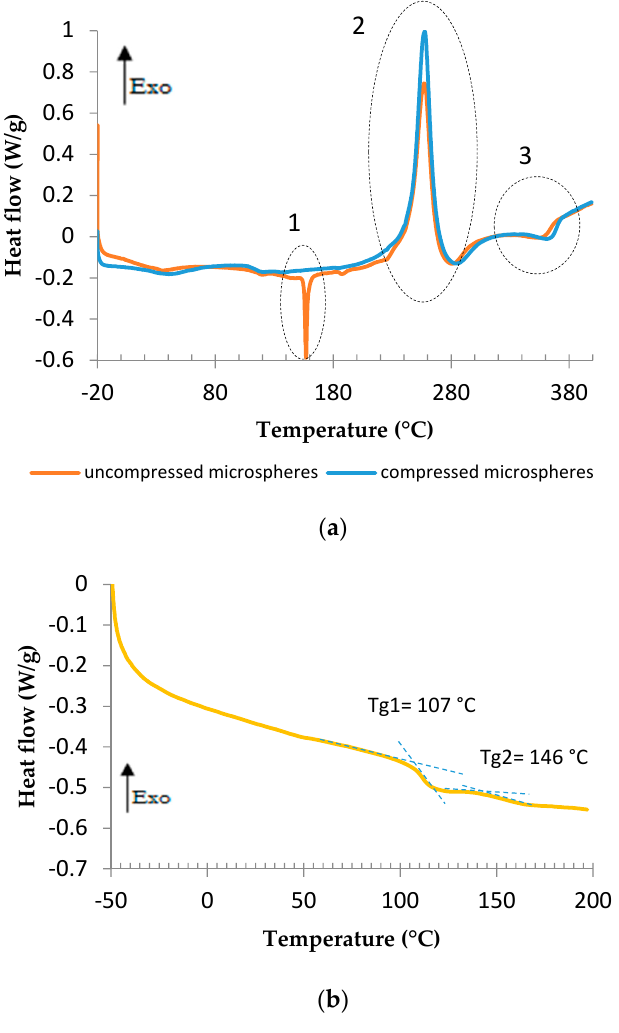
Figure 4 . DSC analyses of compressed and uncompressed microspheres at 3 °/min, with the three major reactions encircled ( a ) and DSC analysis performed on compressed microspheres (second heating) for the determination of glass transitions at 10 °C/min ( b ).